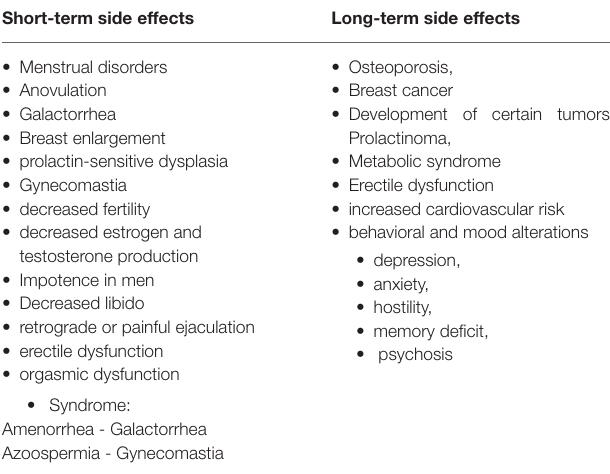
TABLE 1 | Manifestations and the consequences of